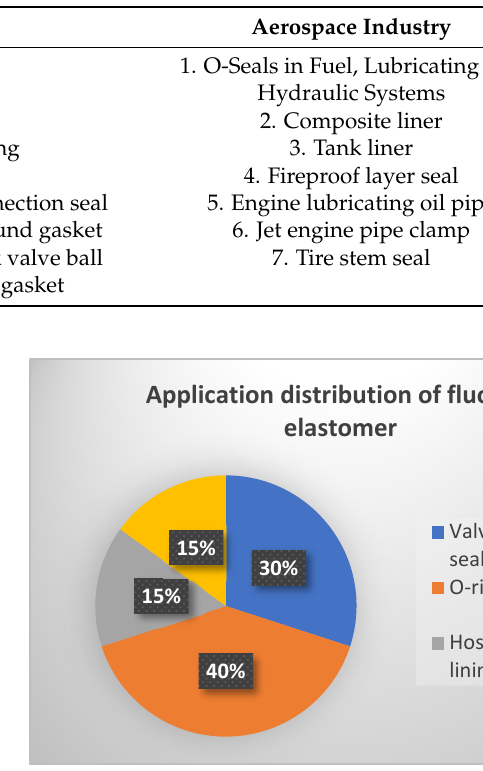
Table 7. Partial applications of fluor elastomers.